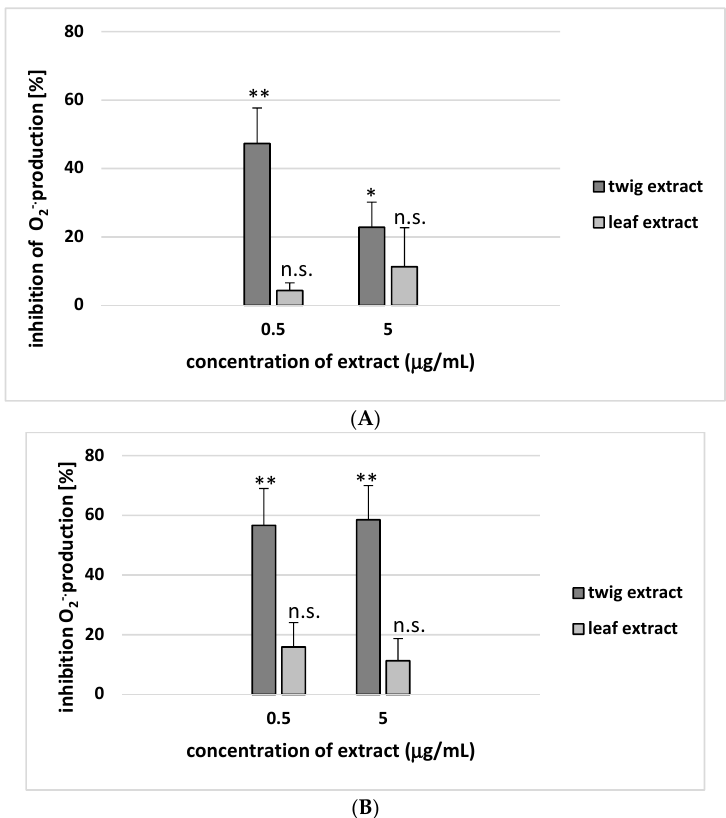
Figure 6. E ff ects of twig and leaf extract (0.5 and 5 µ g / mL; 30 min) on O 2 − production in resting